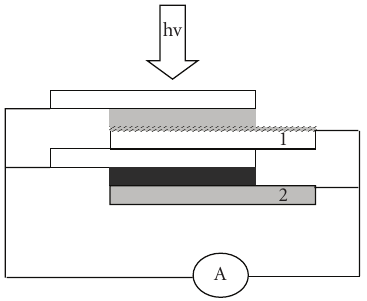
Figure 21: In parallel connected stacked cell based on the Co(II)/(III) couple. 1 is a transparent FTO cathode modified via chemisorption of an electroactive molecule. 2 is a conventional gold cathode. The red and the blue dyes, absorbing in complementary spectral regions, result in a panchromatic sensitization.